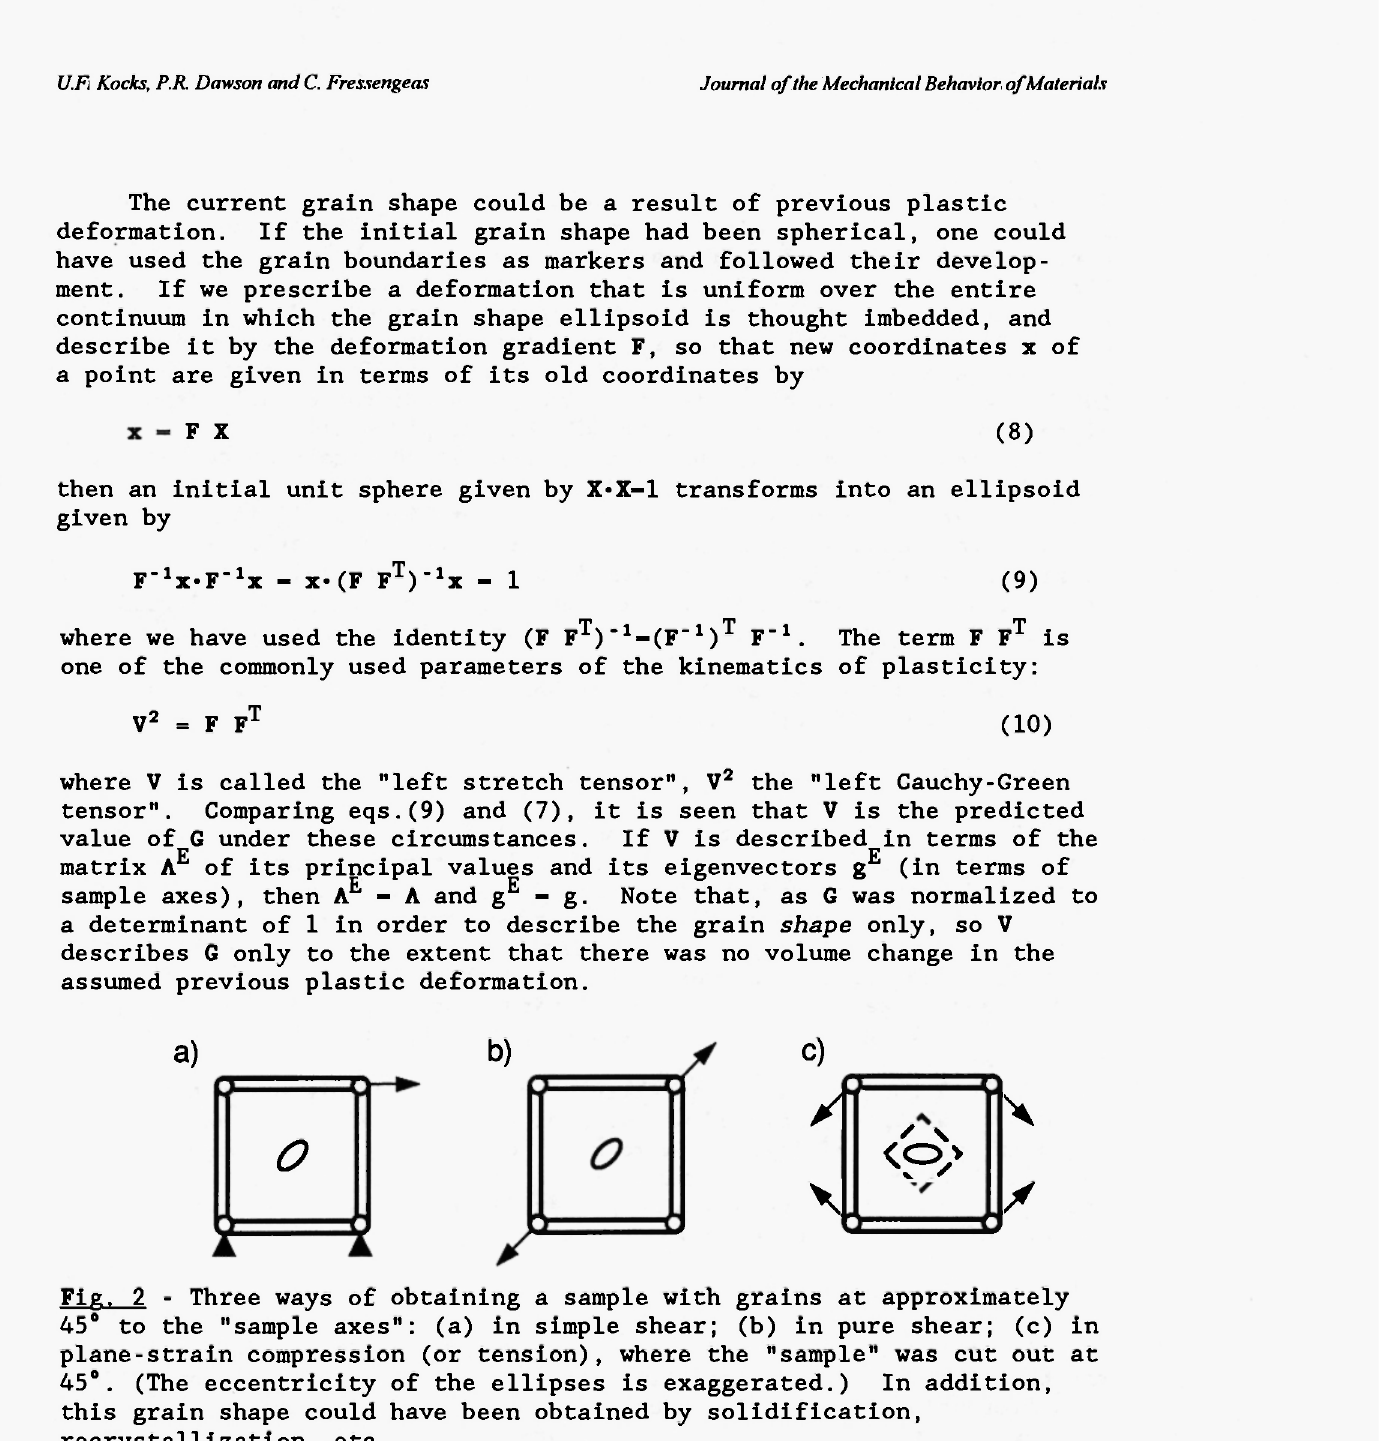
Fig. 2 - Three ways of obtaining a sample with grains at approximately 45° to the "sample axes": (a) in simple shear; (b) in pure shear; (c) in plane-strain compression (or tension), where the "sample" was cut out at 45°. (The eccentricity of the ellipses is